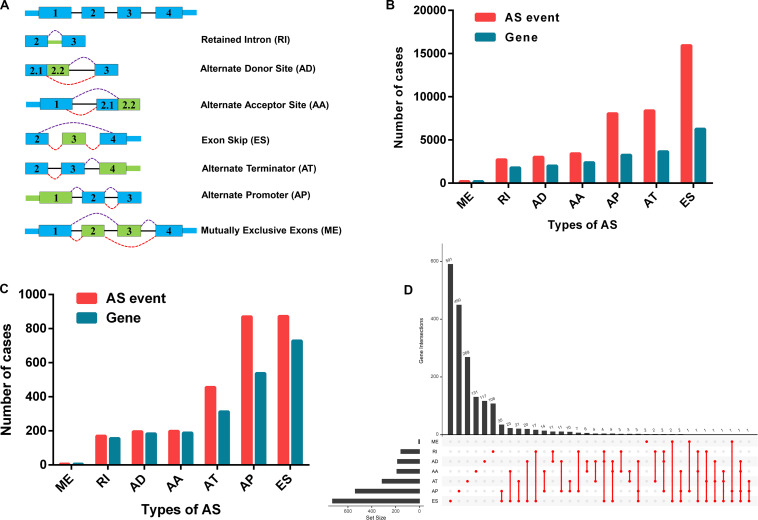
Prognosis-associated alternative splicing (AS) events. (A) Sketch map for the seven types of AS events in this research. (B) The number of AS events and associated genes in the TCGA CC cohort. (C) The number of prognosis-associated AS events and involved genes from the 307 patients with CC. (D) The UpSet plot showed the interactions between the seven types of survival-related AS events in CC. One gene may have up to four types of AS events related to patient prognosis.